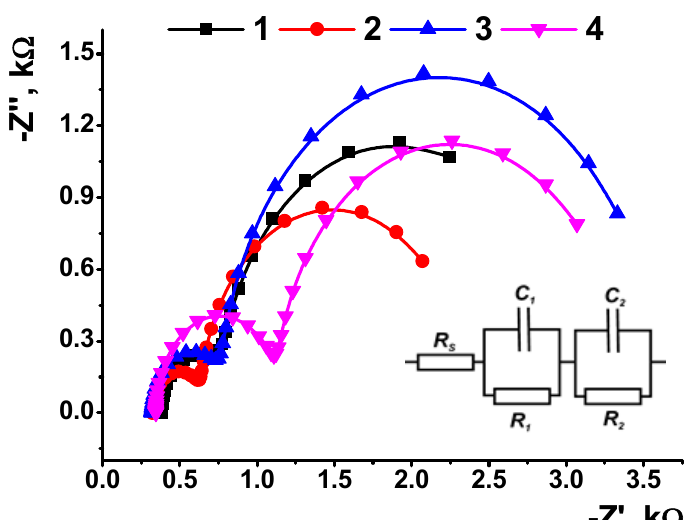
Figure 4. The Nyquist diagrams of the impedance spectra recorded on the GCE covered with CB (1), CB/DNA (2), CB/TC/DNA (3) and after 10 min incubation in 1.0 nM doxorubicin (4). Frequency ranged from 100 kHz to 0.04 Hz, amplitude of the applied sine potential 5 mV, 0.1 M HEPES, pH = 7.0. Inset: equivalent circuit applied for the EIS data fitting. R is the charge transfer resistance and C constant phase element, R s is the electrolyte resistance. Index 1 corresponds to the solution–modifier interface and index 2 to that of electrode–modifier interface. Table 1. EIS parameters corresponded to various steps of the surface layer assembling (average ± S.D., four electrodes).